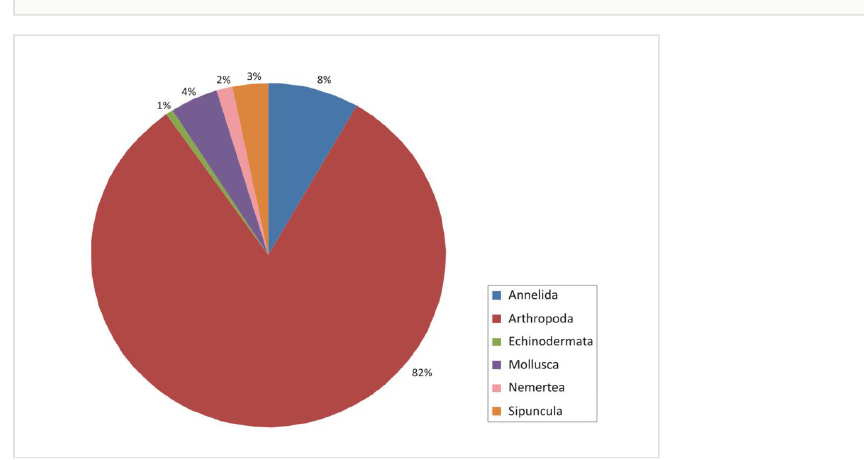
Figure 4. Percentages of main phyla in the summer samples of Cyprus, as calculated based on the individual count of species per total sponge volume.